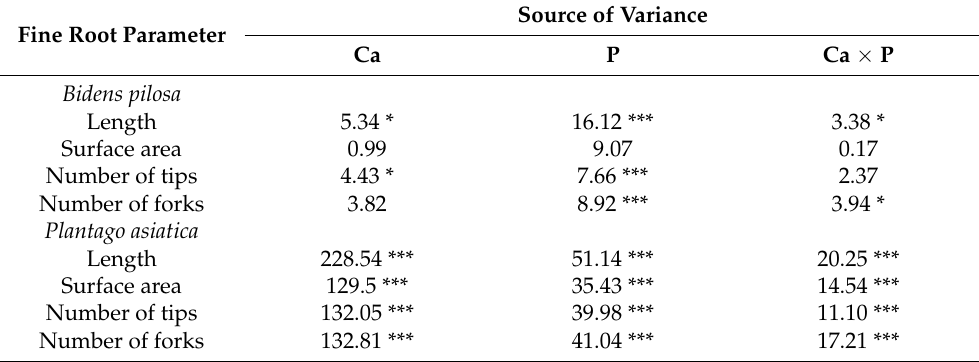
Table 1. Analysis of variance (ANOVA) of calcium (Ca) and phosphorus (P) concentrations and their interaction (Ca × P) on fine root parameters of individuals in Bidens pilosa L. and Plantago asiatica L.